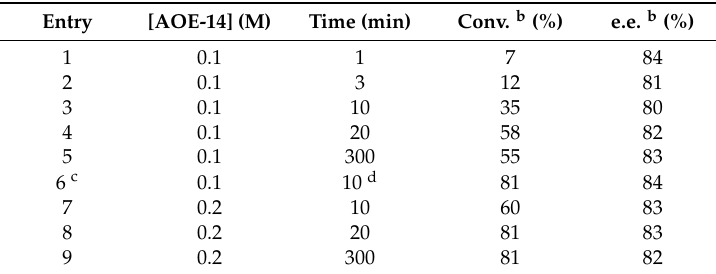
Table 1. Enantioselective epoxidation of 6-CN-2,2-dimethylchromene with H 2 O 2 catalyzed by (salen)Mn(III) in H 2 O in the presence of AOE-14 at 25 ˝ C.